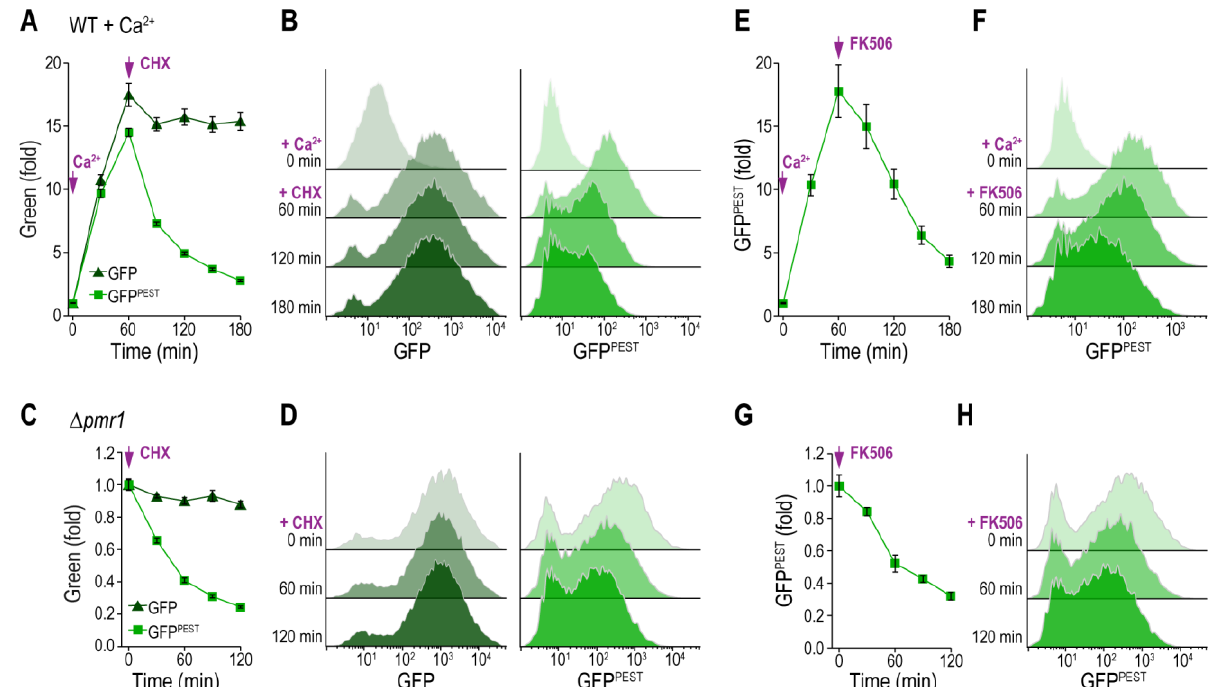
FIGURE 3: GFP PEST as a reporter for transient changes in CN activity. (A-D) Flow cytometric quantification of GFP intensities (A, C) and corre- sponding histograms of selected time points (B, D) after addition of cycloheximide (CHX) to wild type cells pre-treated with 50 mM Ca 2+ for 1 h (A, B) or to  pmr1 cells (C, D) equipped with either pAMS366-4xCDRE-GFP or pAMS366-4xCDRE-GFP PEST . (E-H) Flow cytometric quantifica- tion of GFP intensities (E, G) and corresponding histograms of selected time points (F, H) after addition of 0.5 µM FK506 to wild type cells pre- treated with 50 mM Ca 2+ for 1 h (E, F) or to  pmr1 cells (G, H) equipped with pAMS366-4xCDRE-GFP PEST . Dead cells were excluded from the analysis via propidium iodide (PI) staining. Means ± SEM, n =